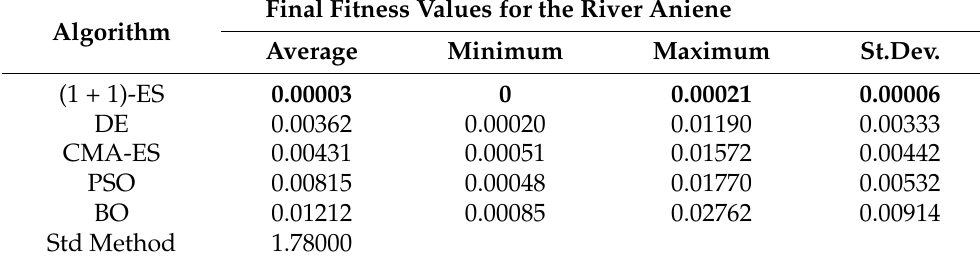
Table 2. Experimental results for the case study 2 river ‘Aniene’. For any meta-heuristic, the table provides the average, minimum, maximum and standard deviation of the fitness values observed at the end of all the 25 executions. For the standard method, which is deterministic, only one result is